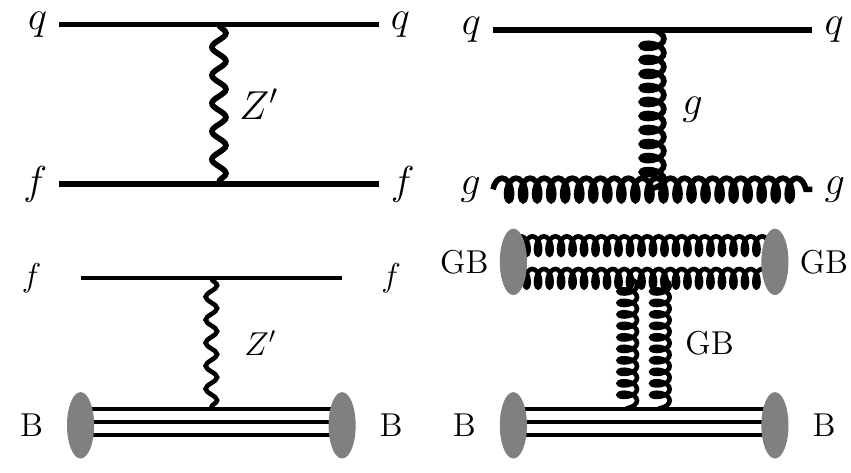
Figure 2 . Diagrams giving rise to heat exchange between different particles in the spectrum before (top) and after (bottom) the confinement PT. One can easily check that the top diagrams keep the dark quarks q in equilibrium with SM fermions f (top left) and with dark gluons g (top right). This suggests the SM and dark gluons remain in kinetic equilibrium as well. After the PT the abundance of all the relics in the dark sector get substantially suppressed and heat exchange rates become much lower. The most efficient diagrams for heat exchange after the PT are shown between the dark baryons and SM fermions (bottom left), and dark glueballs and baryons (bottom right). These diagrams can not maintain the kinetic equilibrium between SM and dark glueballs after the PT, see text for further